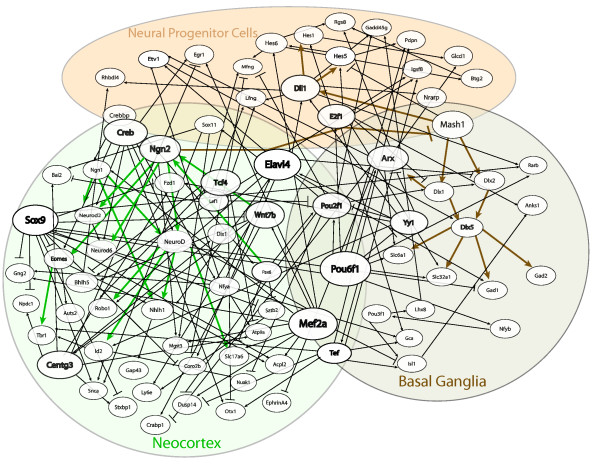
Algorithm-based gene regulatory network structure for dorsal and ventral telencephalon development. The Bayesian-based TAO-Gen algorithm was implemented with an informative prior structure to predict the optimal network structure based on the LOF and GOF microarray datasets, evolutionarily conserved TFBS data, prior literature-based knowledge, and spatial and time-specific expression patterns. To highlight the key regulators, the nodes representing genes predicted to be the parent of at least nine other genes are largest in size (Sox9, Mef2a, Elavl4 and Pou6f1), whereas those that are predicted to regulate at least five other genes are medium in size (Ngn2, Centg3, Tef, Tcf4, Wnt7b, Pou2f1, Yy1, Dll1, E2f1, Arx, and Creb). See Additional file 11 for matrix of connectivity and Methods for a more detailed description of algorithm.